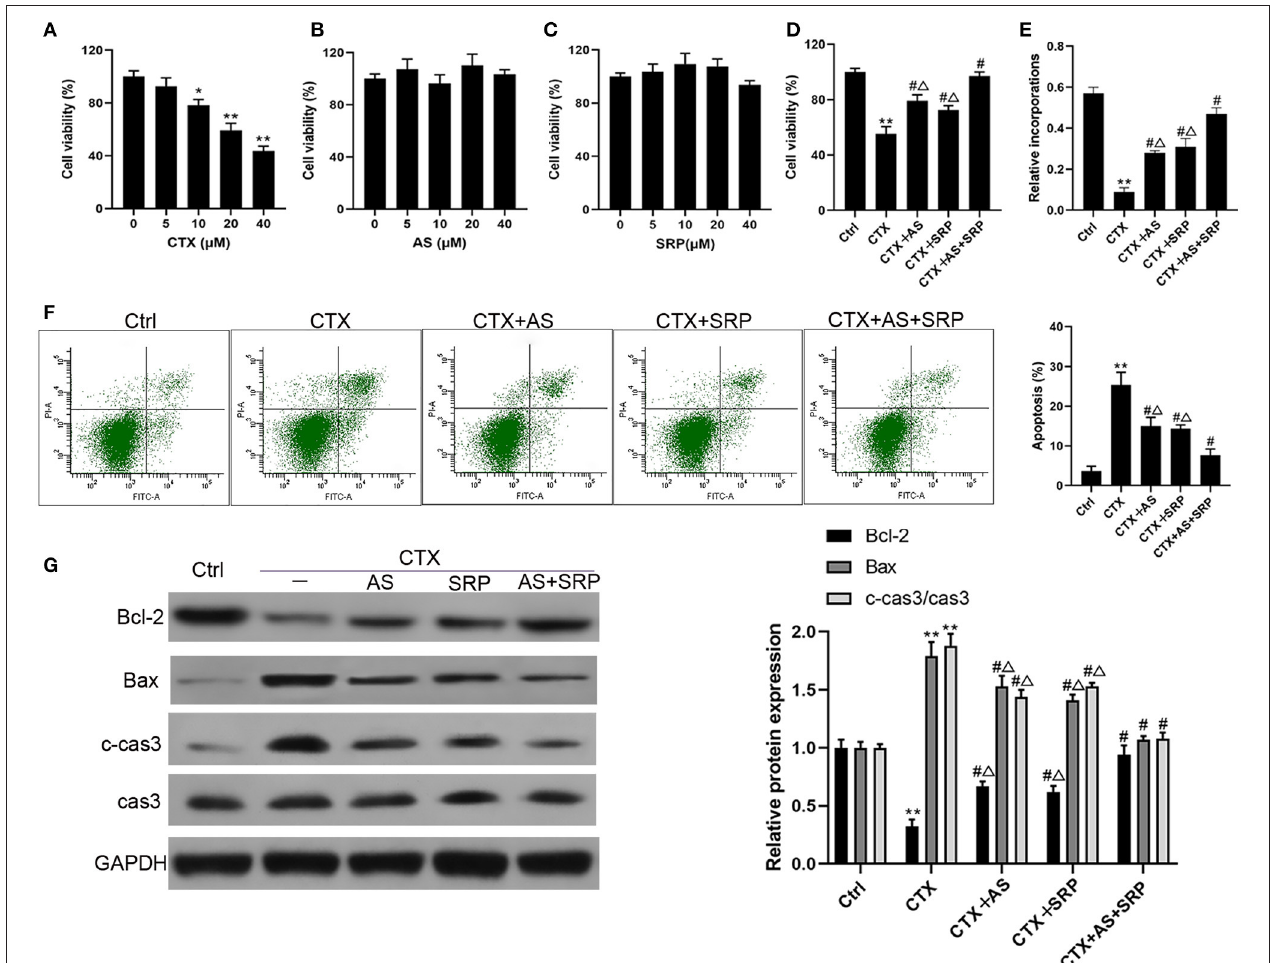
FIGURE 1 | Astragaloside IV (AS) and saponins of rhizoma polygonati (SRP) alleviated cyclophosphamide (CTX)-induced cell injury in bone marrow hematopoietic stem cells (BMHSCs). BMHSCs were treated with CTX, AS, or SRP at various concentrations that range from 0 to 40 µ M, 20 µ M CTX + 5 µ M AS, or 20 µ M CTX + 10 µ M SRP for 48h. (A – D) Cell viability was measured by CCK-8 assay. (E) Cell proliferation was measured by BrdU assay. (F) Apoptosis was detected by Annexin V-PI staining. (G) Protein expressions of Bcl-2, Bax, and c-cas3/cas3 were determined by Western blot. * P < 0.05, ** P < 0.01 vs. Ctrl group; # P < 0.01 vs. CTX-alone group; 1 P < 0.05 vs. CTX + AS + SRP group; n =